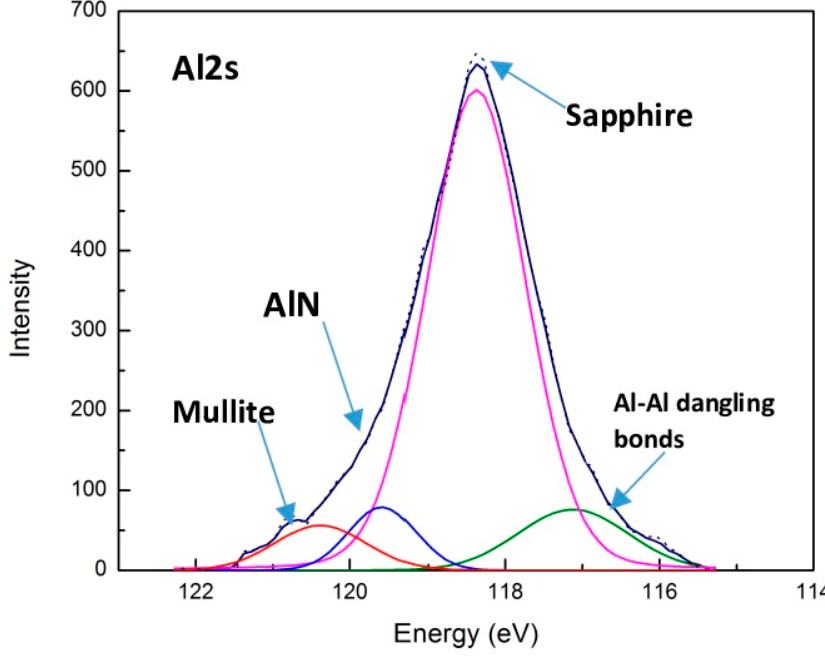
Figure 8. XPS data for tribo-films formed on the worn surface of multilayer TiAlCrSiYN / TiAlCrN thin film coating during running-in stage (after turning of 1000 m): Photoelectron Al2s spectra on the rake surface of the worn coated tool tested. Reproduced from [31].